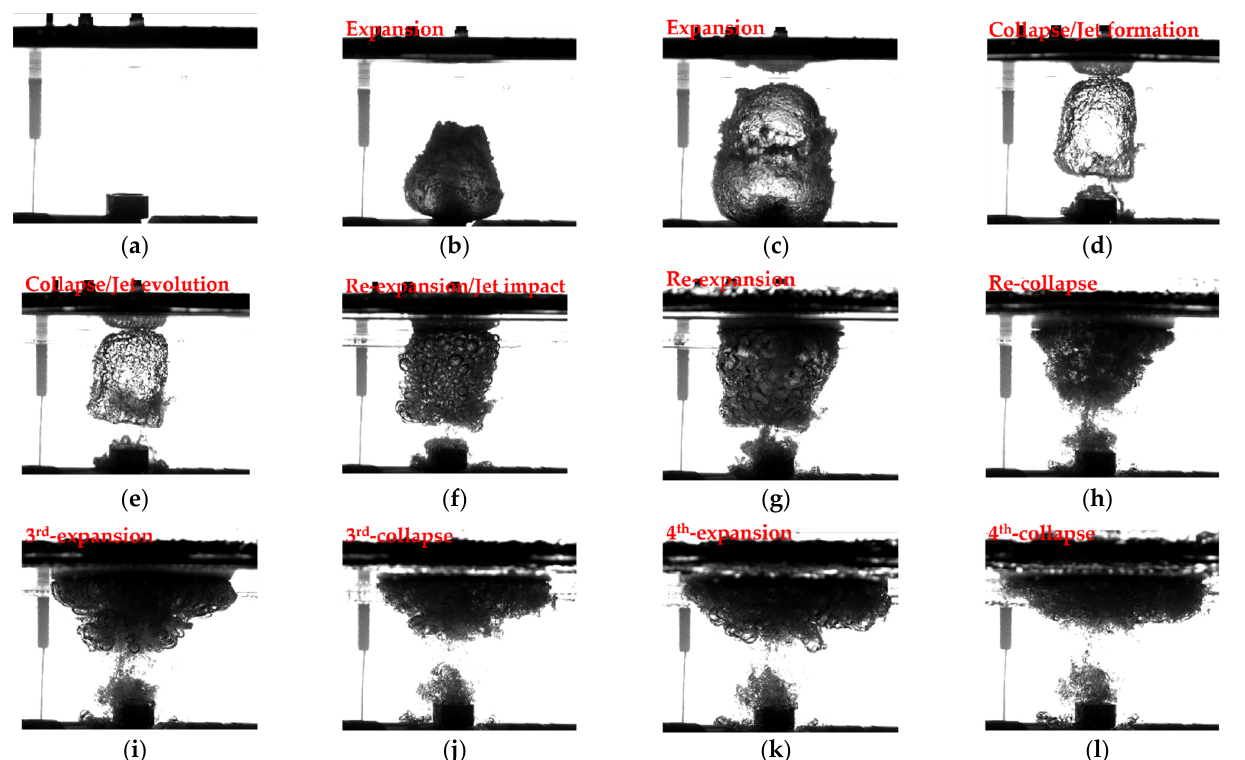
Figure 6. Image of underwater airgun bubble near a rigid wall. ( a ) t = 0 ms, ( b ) t = 1.95 ms, ( c ) t = 5.00 ms, ( d ) t = 8.35 ms, ( e ) t = 8.85 ms, ( f ) t = 10.80 ms, ( g ) t = 13.35 ms, ( h ) t = 16.00 ms, ( i ) t = 18.90 ms, ( j ) t = 23.65 ms, ( k ) t = 27.35 ms, ( l ) t = 31.05 ms.